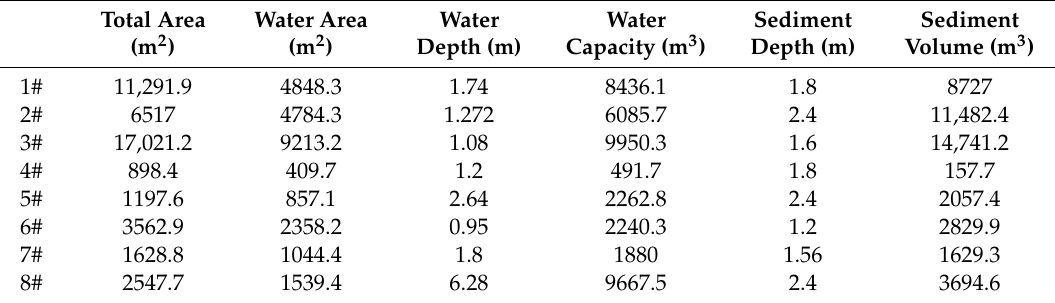
Table 1. Information about the sampling